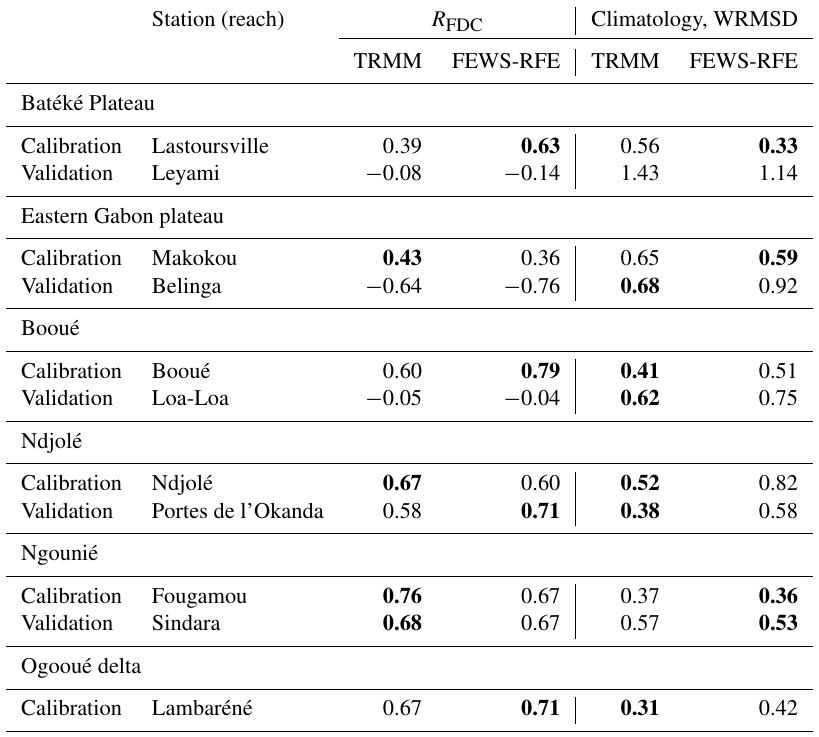
Table 4. Performance measures for the TRMM and FEWS-RFE models based on the discharge observations. Values in bold highlight the best validated performance.